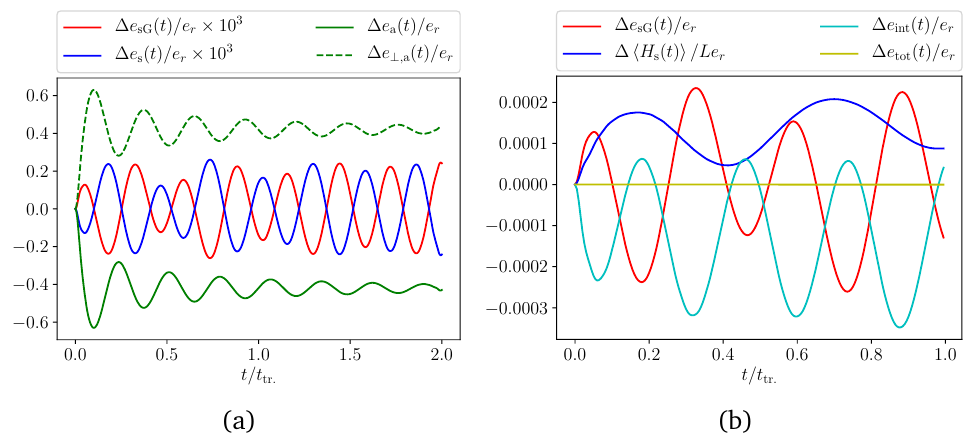
Figure 5: Energy flow between the different terms in Eqs. (83), as a ratio with the = 〈 H ( 0 ) 〉 / L . reference scale e r s